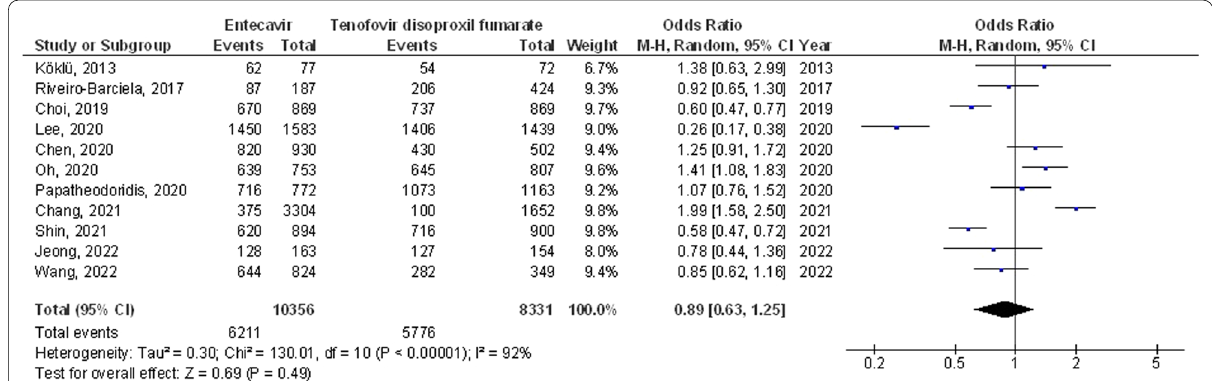
Fig. 4 Difference between the impact of entecavir and tenofovir disoproxil concerning the results of virological responses in chronic HBV subjects